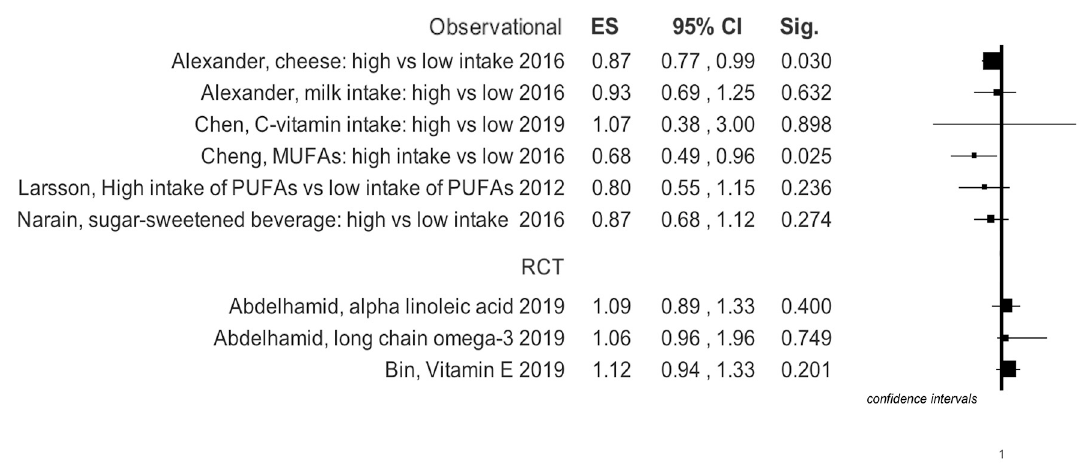
Figure 6. Summary results of effects size for hemorrhagic of stroke events, based on study design of selected primary studies for each meta-analysis.